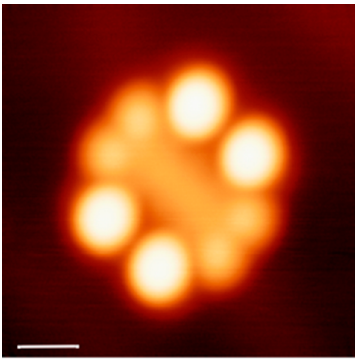
Figure 6. Image of the curved nanocar 17 on Au(111). The four bright spots correspond to the four triptycene wheels (U = 1.1 V, I = 5 pA). Scale bar: 1 nm.